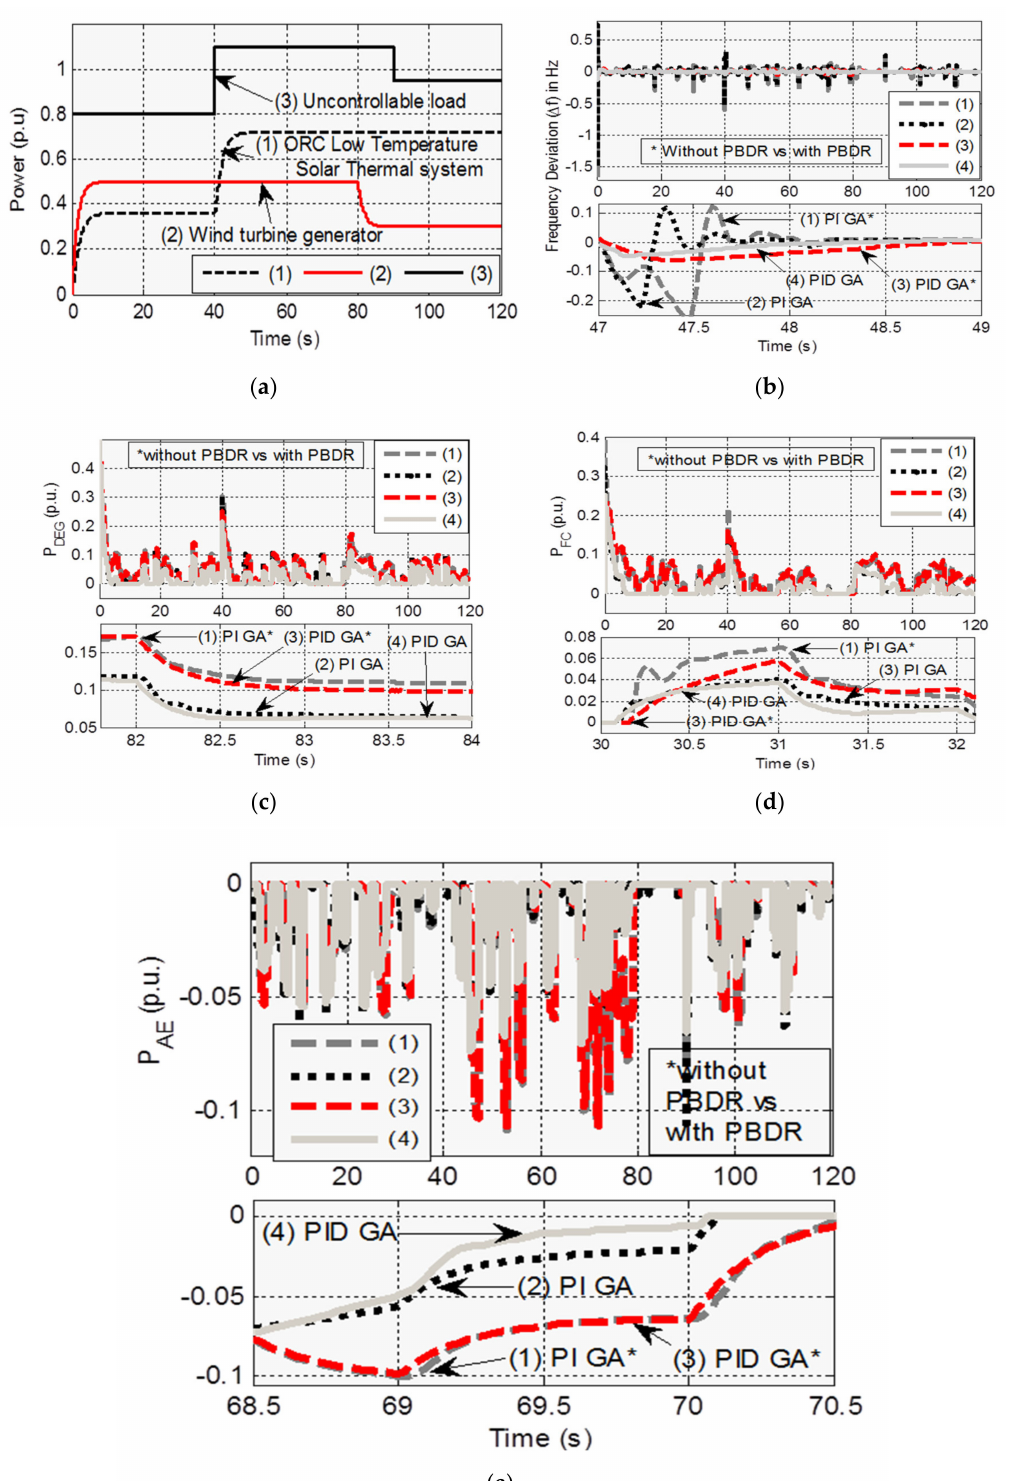
Figure 3. ( a ) Extractable power of the the wind turbine generator ( WTG ), solar thermal power system ( STPS ) and thermostatically controllable load. ( b ) Comparison of the frequency deviation, without and with price-based demand response (PBDR). The power extraction of ( c ) a diesel engine generator ( DEG ), ( d ) a fuel cell ( FC ) and ( e ) an aqua electrolyzer ( AE ) without and with PBDR is also